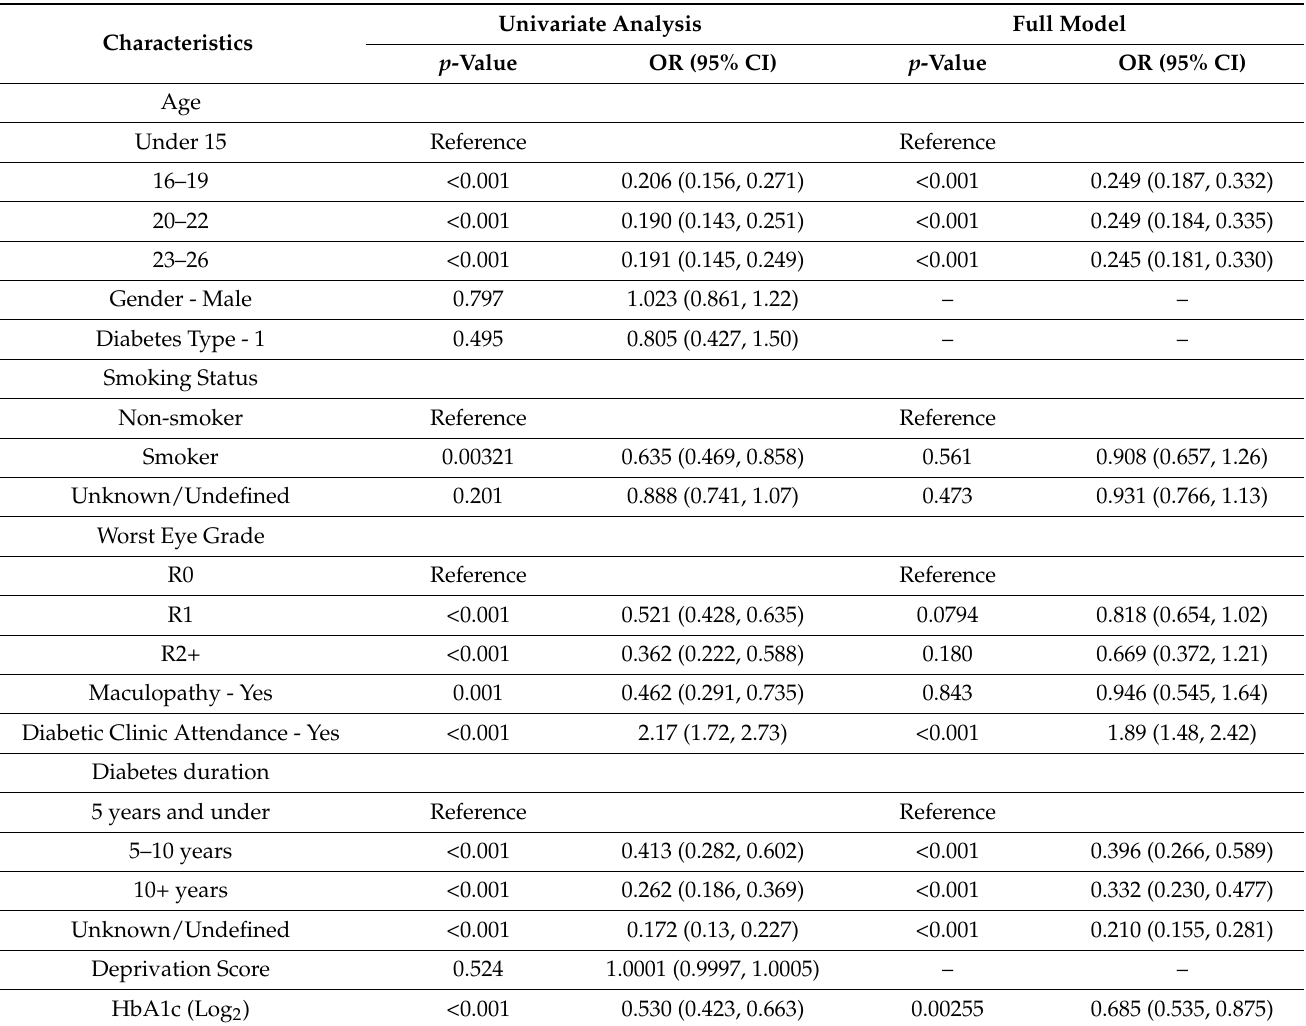
Table 2. Logistic Regression Analysis—Univariate (all variables) and full model analysis (significant variles).